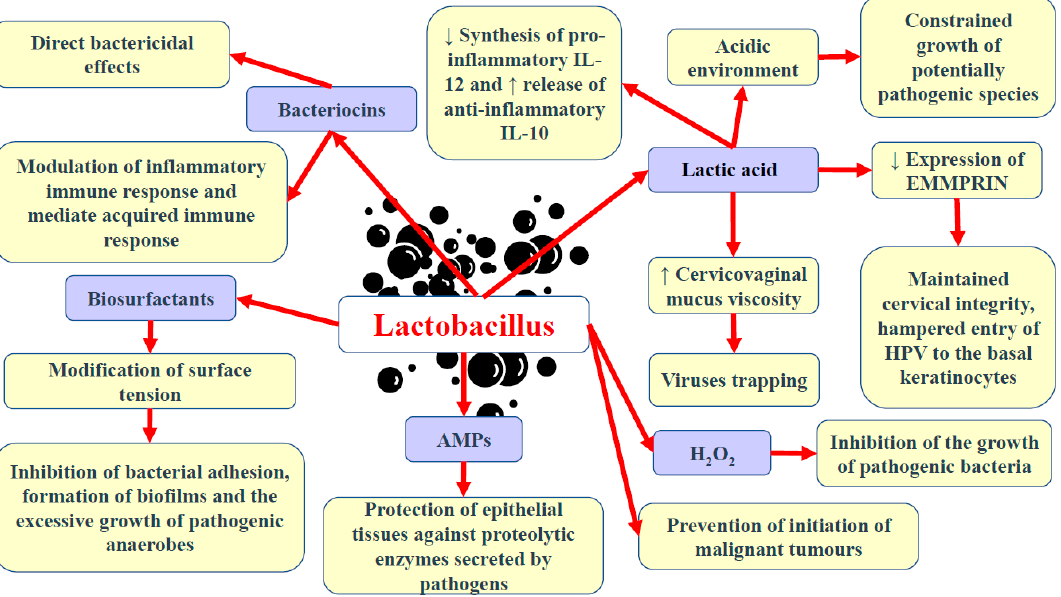
Figure 1. Basic beneficial mechanisms of Lactobacillus in the female genital tract. Abbreviations: ↓ —decrease; ↑ —increase; AMPs—antimicrobial peptides; H 2 O 2 —hydrogen peroxide; EMMPRIN— extracellular matrix metalloproteinase inducer; IL-10 and -12—interleukin-10 and